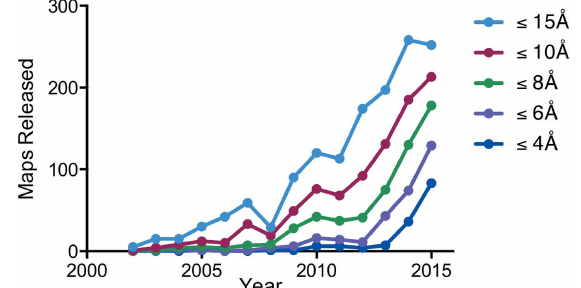
Figure 1 Growth in number of cryoEM structures deposited at the Electron Microscopy Data Bank since 2002 (taken from the PDB website: http:// pdbe.org/emstats). There is exponential growth at all resolution ranges, and a dramatic increase in the number of structures with resolutions better than 4 A˚ . Earlier studies that represent landmarks in the development of single-particle cryoEM were the hepatitis B capsid determined at 7.4 A˚ resolution (Bo¨ttcher et al. , 1997; Conway et al. , 1997) and the E.coli 70S ribosome at 11.5 A˚ resolution (Gabashvili et al. , 2000).